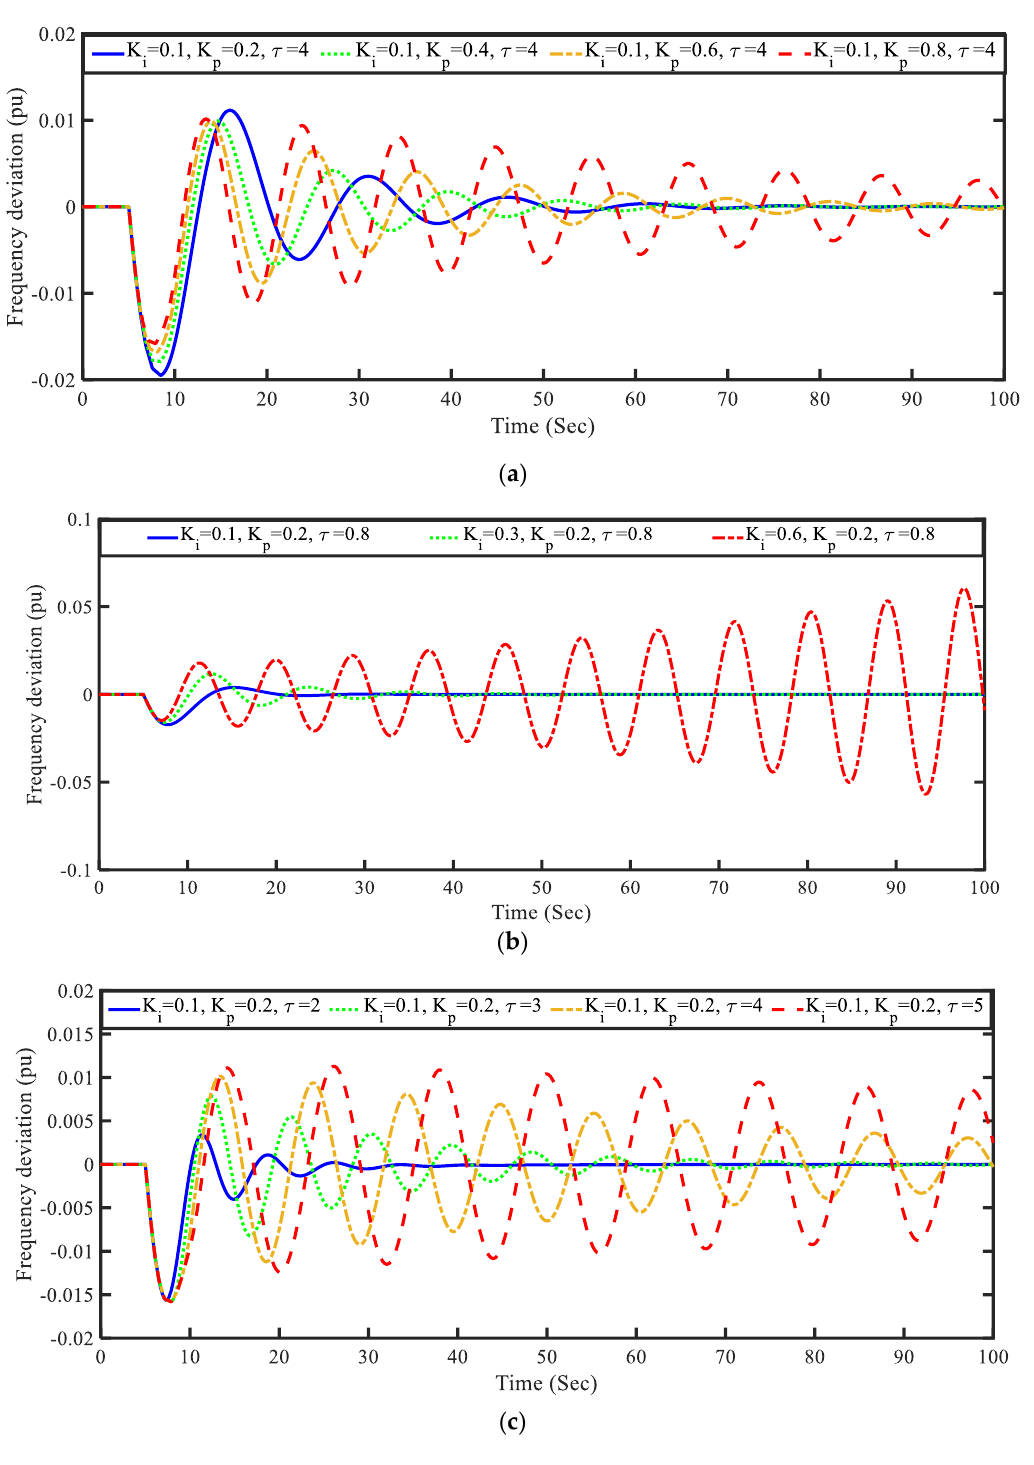
Figure 10. Effect of changing the PI controller and delay parameters on the LFC system. ( a ) K P variation, ( b ) K i variation, ( c ) delay